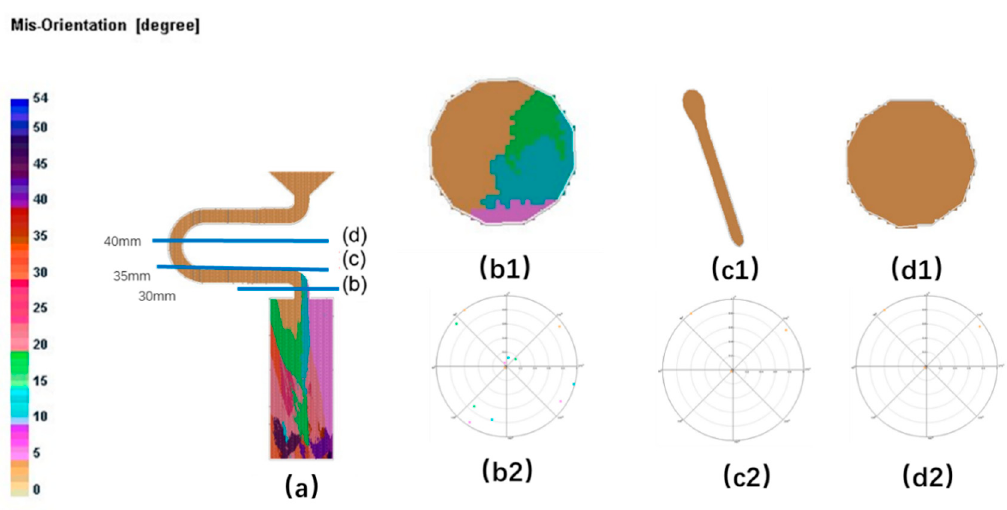
Figure 15. Simulation structure of C 5 (20 mm) ( a ); EBSD maps of the grain structure evolution ( b1 , c1 , d1 ) and the EBSD inverse pole figures ( b2 , c2 , d2 ).